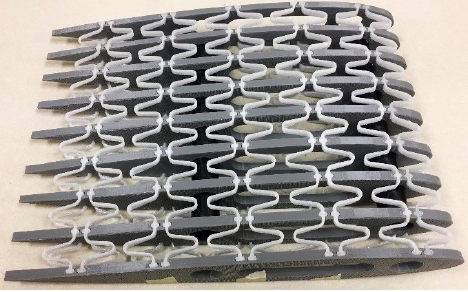
Figure 10. The assembled honeycomb substructure.